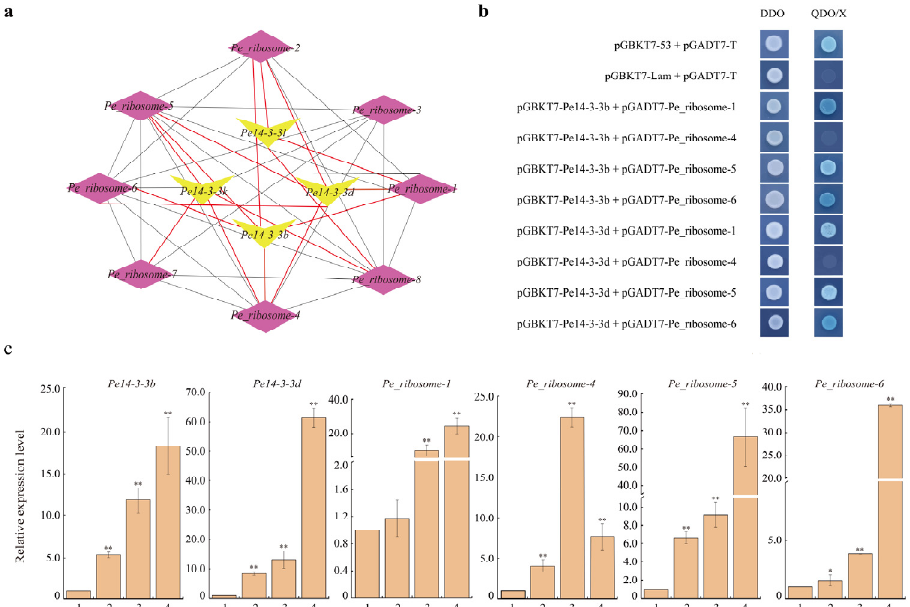
Figure 5. Relationship validation of Pe14-3-3s and Pe_ribosomes. ( a ) The co-expression network of four Pe14-3-3 s with eight Pe_ribosome s, which had a strong correlation (PCC > 0.75, p -value < 0.05). The black and red lines indicate the co-expression relationship within Pe_ribosome s and those between Pe_ribosome s and Pe14-3-3 s, respectively. ( b ) Y2H assay between Pe14-3-3b/d and Pe_ribosomes. Positive control, co-transformation with pGBKT7-53 and pGADT7-T; negative control, co-transformation with pGBKT7-Lam and pGADT7-T; DDO: SD/-Leu/-Trp, QDO/X: SD/-Ade/-His/-Leu/-Trp supplemented with X- α -Gal. ( c ) Expression analysis of Pe14-3-3b / d and four Pe_ribosome s in shoots with different heights (1: 0.5 m, 2: 1.0 m, 3: 4.0 m, 4: 6.0 m; the asterisks indicate the significant difference between the relative expression levels in different height shoots and that in 0.5 m shoots, * p < 0.05 and ** p < 0.01).